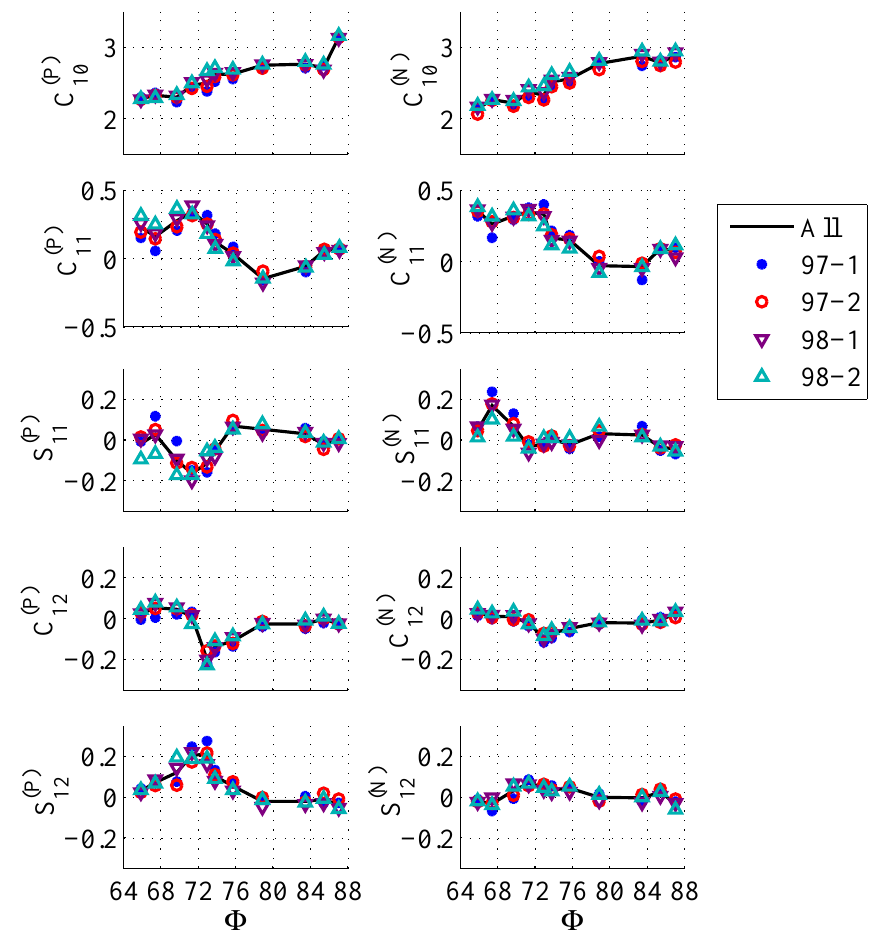
Fig. 6. Coefficients of the Fourier expansion (6) of the spectral slope α for the P-component (left) and the N-component (right) in the same format as in Fig.